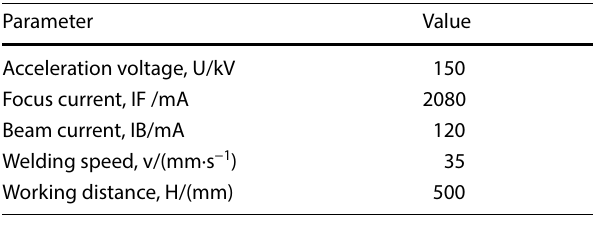
Table 1 Chemical composition of WE43 magnesium alloy (mass fraction,